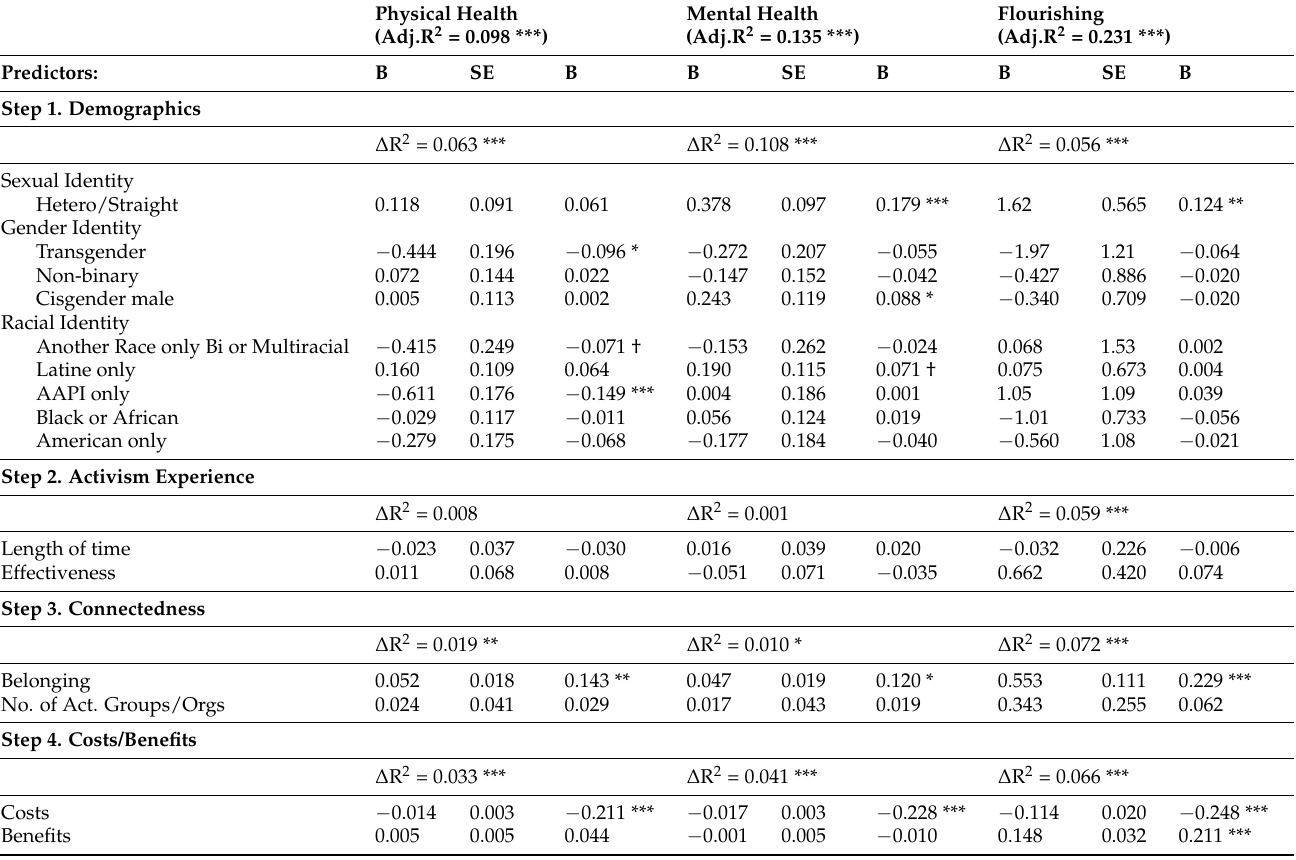
Table 3. Regression Models for Health and Wellbeing (coefficients and Adj.R 2 shown are for final step with all variables included, ∆ R 2 indicates the change in R 2 at each step). Physical Health Mental Health Flourishing (Adj.R 2 = 0.098 ***) (Adj.R 2 = 0.135 ***) (Adj.R 2 = 0.231